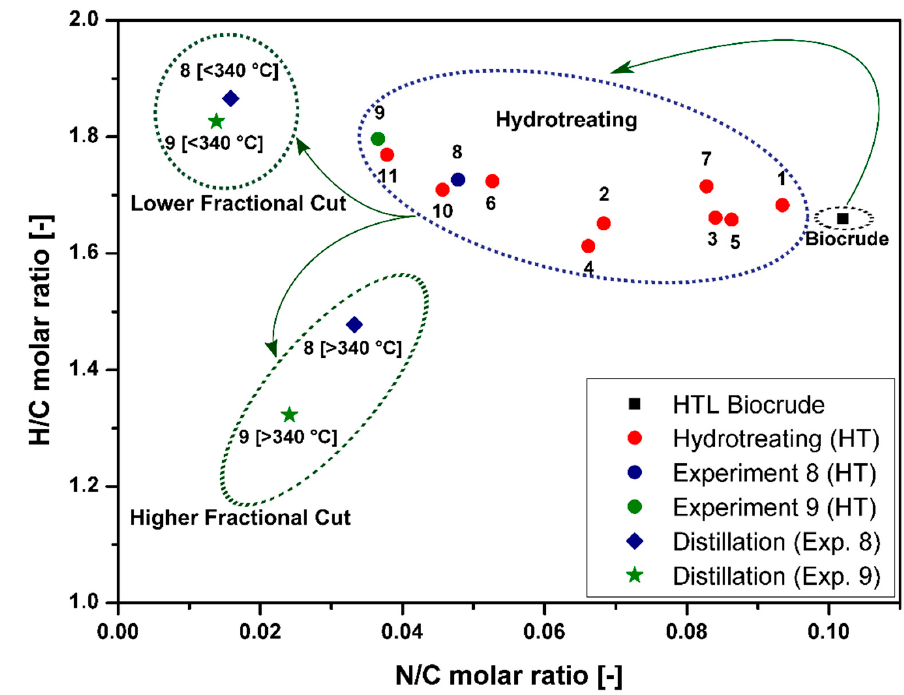
Figure 4. Modified Van Krevelen diagram showing molar ratio of H/C as a function of N/C for Spirulina feedstock, HTL biocrude, 11 hydrotreating experiments and fractional distillation cuts of experiment 8 and 9.